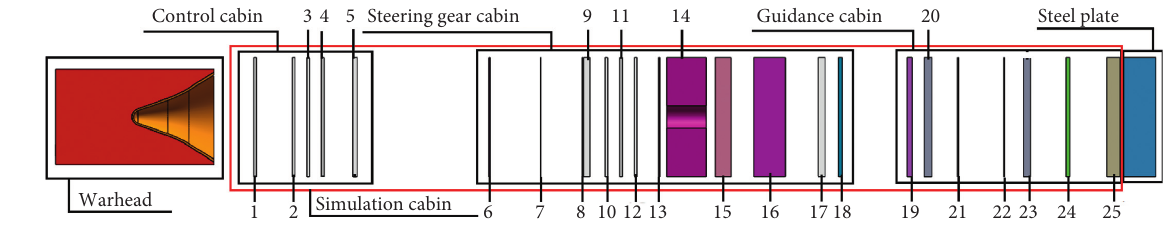
Figure 2: Equivalence principle